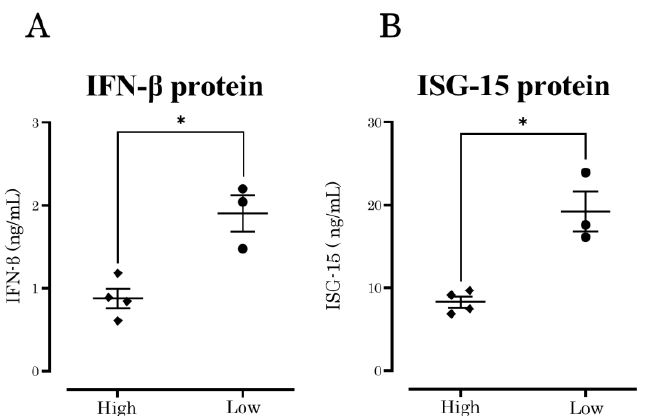
Figure 2. IFN- β and ISG-15 protein expression differed in IAVs with high and low growth capabilities. ( A ) IFN- β protein expression at 24 h post-infection was significantly increased ( p = 0.0067) in IAV strains with a low growth capability compared with those with a high growth capability. ( B ) ISG-15 protein expression 24 h post-infection also showed the same pattern ( p = 0.0038). p values of ≤ 0.05 is given one asterisk (*).